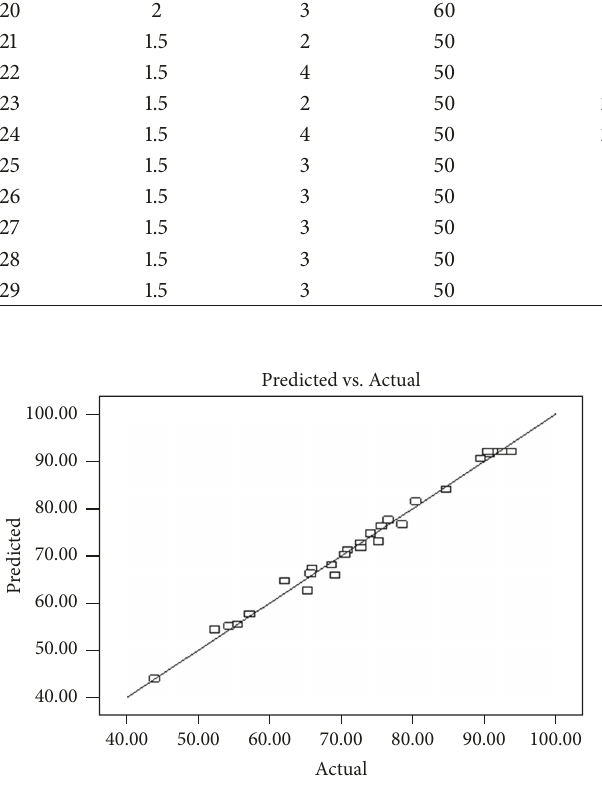
to 1 of the 𝑥 -axis. From Figure 2, all the data are near the line which meant the predicted values are close to experimental values, indicating that the model is successful in capturing